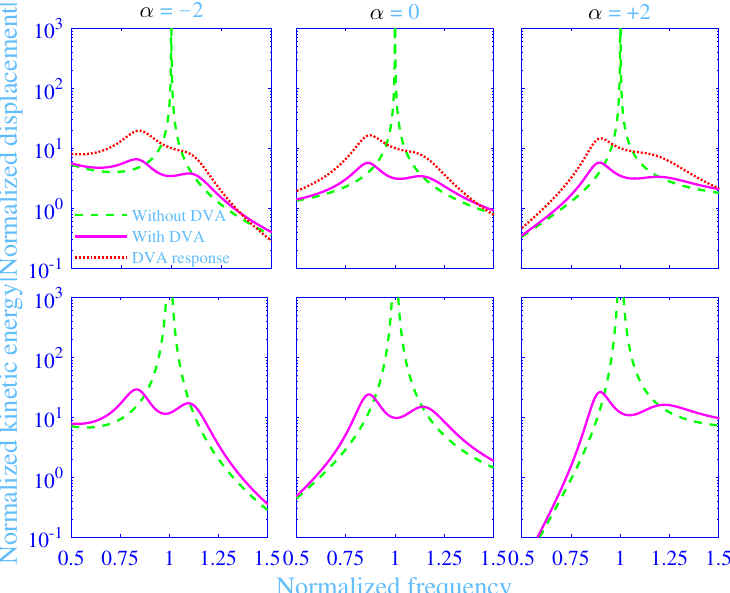
Figure 5. Absolute value of the normalized displacement and the normalized kinetic energy of the mass M versus the normalized frequency with and without the dynamic vibration absorber (DVA) together with the absolute value of the normalized displacement of the mass m versus the normalized frequency, at various normalized frequency dependencies of the excitation force α , with C = 0.04 and χ =